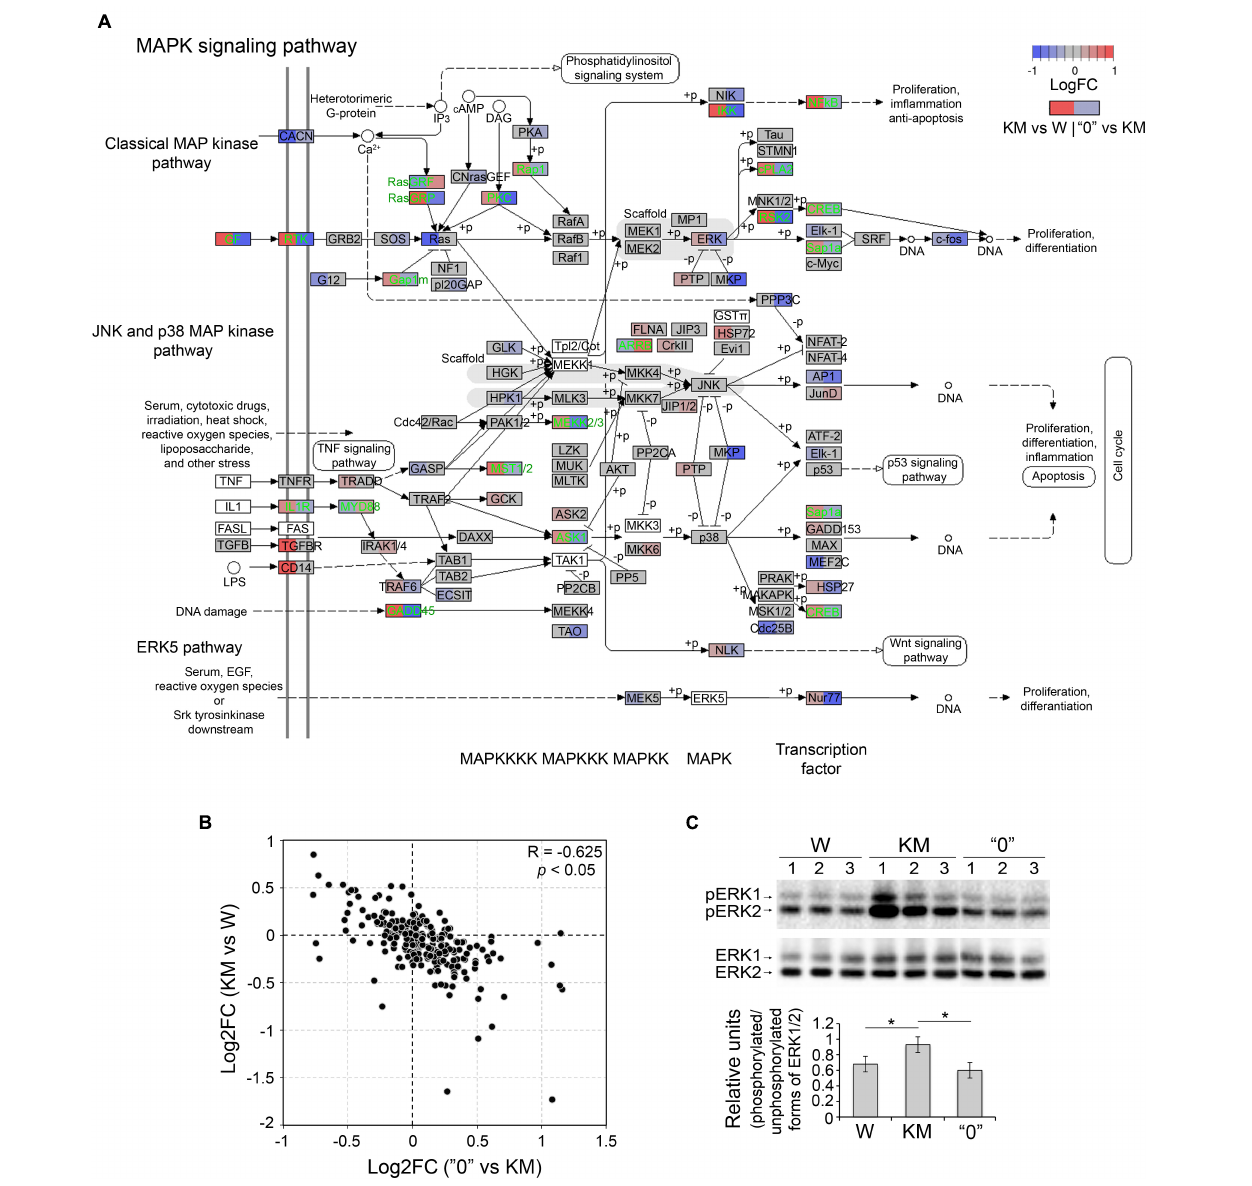
FIGURE 3 | The expression of MAPK pathway and ERK1/2 genes was alleviated in “0” rats. (A) Differential expression of genes participating in the MAPK pathway (rno04010). Gene expression changes are shown in color (log2-scale; LogFC; red – upregulation, blue – downregulation, gray – no change, white background – the absence of expression). Each gene block is divided into two sections (the left block shows differential expression between KM and W rats; right – between “0” and KM samples). Genes that demonstrate opposite changes between two pairs of comparisons (“compensated” genes) are shown in green font. (B) Scatter plot depicting the pairwise comparison of log2-fold changes between the KM vs W and “0” vs KM groups. R – Spearman’s correlation coefficient. (C) Western blot analysis of phosphorylated and unphosphorylated forms of ERK1/2 ( top ) and the calculation of the optical density of the signals ( bottom ). For semiquantitative estimation, the optical density of phosphorylated ERK1/2 was subjected to two levels of normalization: first between samples and second on the unphosphorylated form of ERK1/2. * p < 0.05, Kruskal-Wallis test with post hoc